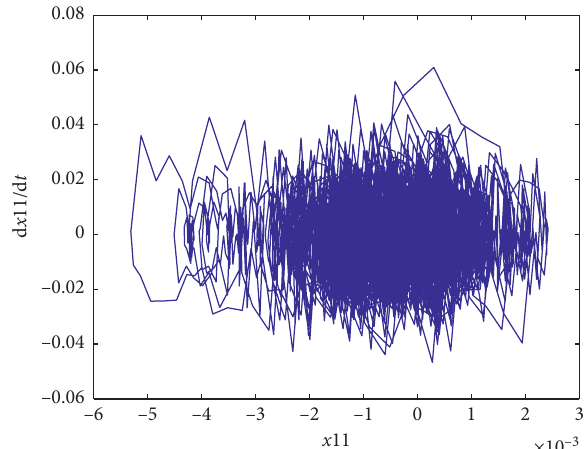
Figure 13: Phase portrait and basin of the attraction set for the active case with η � 100000 and λ � 1.